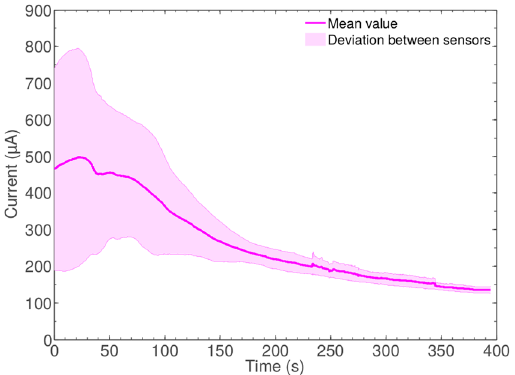
Figure 3. Transient sensor behaviour using a TMB electrolyte (OD 0.5 by colorimetric analysis). All sensors converge to an equilibrium point after a threshold time value ( > 400 s), which has been selected as a starting point for each measurement herein.